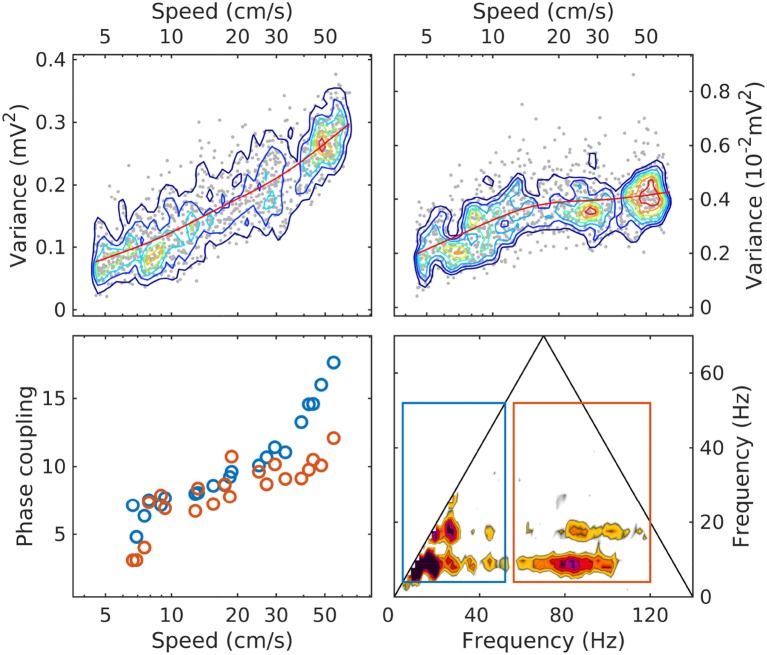
The evolution with speed of LM theta power (upper left); gamma power (upper right; note the different units); phase coupling of theta and its harmonics (lower left, blue); phase coupling of theta and gamma (lower right, red). The phase coupling measure is the bicoherence integrated over the area of the rectangles shown in the lower-right panel (same colors as in lower-left panel). Because the bicoherence is normalized, the units of the phase coupling measure are arbitrary. In upper panels, the red line is a moving average, included to highlight the evolution trend.